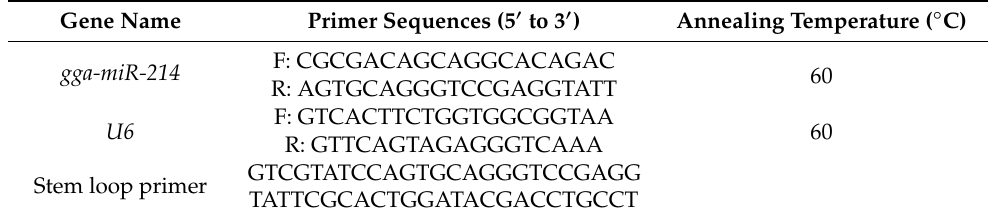
Table 2. Related primer sequence information in the miR-214 quantitative experiment.